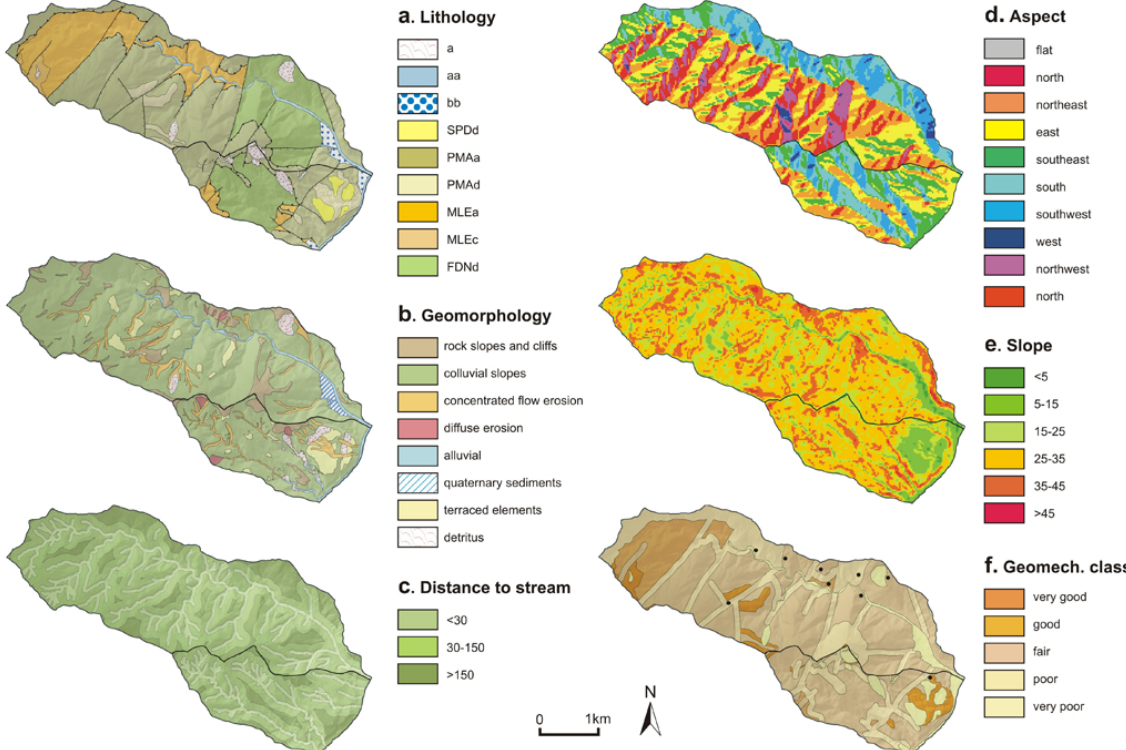
Fig. 4. Spatial distribution of the six causative factors: (a) bedrock lithology and lineaments (abbreviations from Messina-Reggio C. Geo- logical Map, Foglio 601 Messina-Reggio C. della Carta Geologica d’Italia, scala 1:50000. APAT, Servizio Geologico d’Italia, Dipartimento Difesa del Suolo, Roma, 2008); (a) slope deposits; aa: present-day alluvial deposits; bb: recent alluvial deposits; SPDd: calcarenites; PMAa paragneiss of the Aspromonte unit; PMAd marble of the Aspromonte unit; MLEa: mica schists of the Mela unit; MLEc: marble of the Mela unit; FDNd: phyllite of the Mandanici unit); (b) : geomorphological units; (c) : distance to stream; (d) : aspect of the slopes; (e) : slope angle (degree); (f) : geomechanical classification of rock types according to the RMR proposed by Bieniawski (1979); black dots indicate the measurement